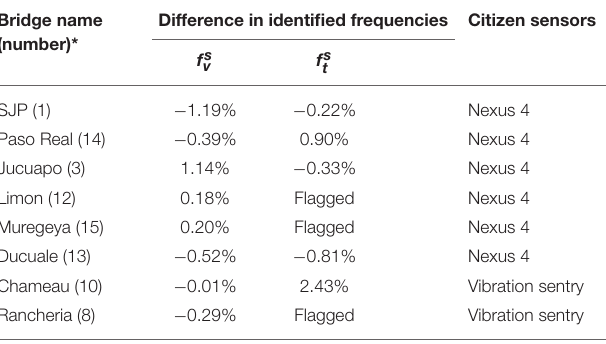
TABLE 6 | Comparison of VS and TS frequencies estimated from wavelet-based SI scheme and batch processing